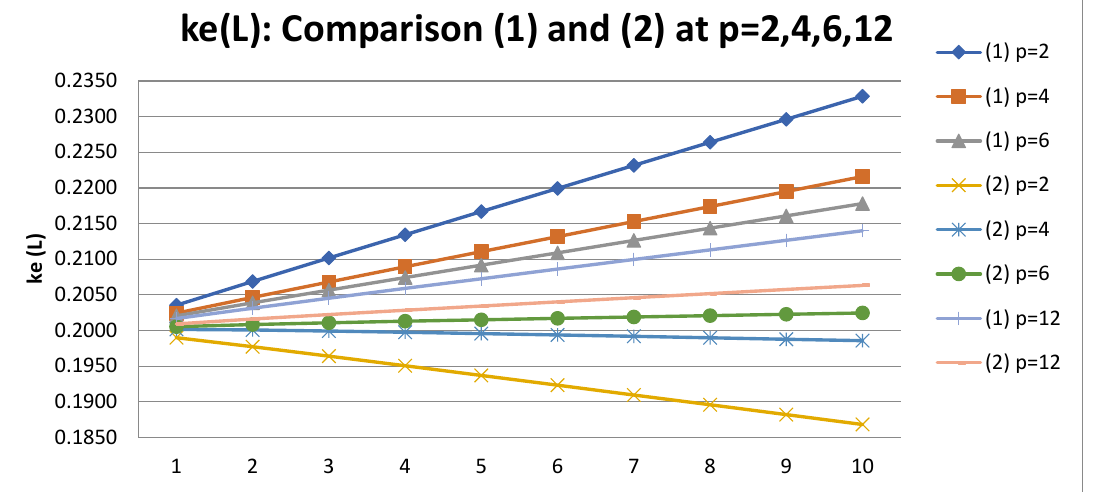
Figure 6. The comparison of the dependence of the equity cost ( ke ) on the leverage level ( L ) of a three-year-old company for profit tax payments that were (1) made at the end of the financial period and (2) made at the beginning of the financial period (i.e., advance payments) with frequencies of p = 2, 4, 6 and 12.